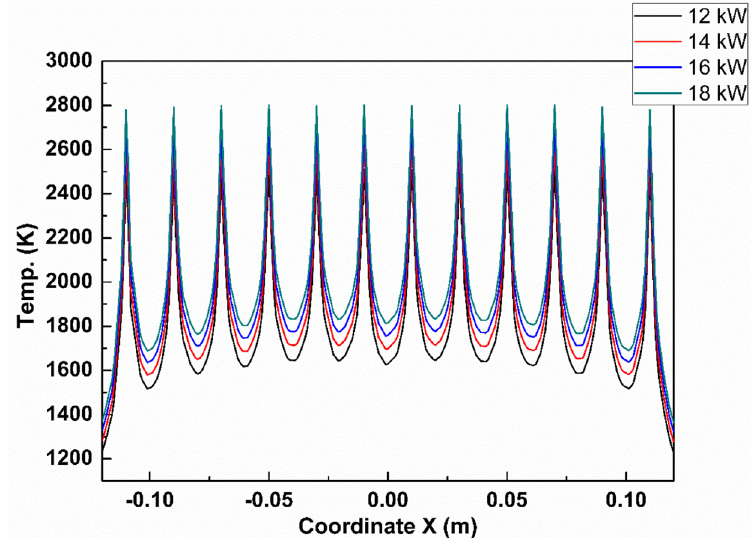
Figure 3. Temperature profiles in filament plane (filaments are 10 mm away from the worktable) along the x ‐ axis at the center of the z ‐ axis according to applied power.